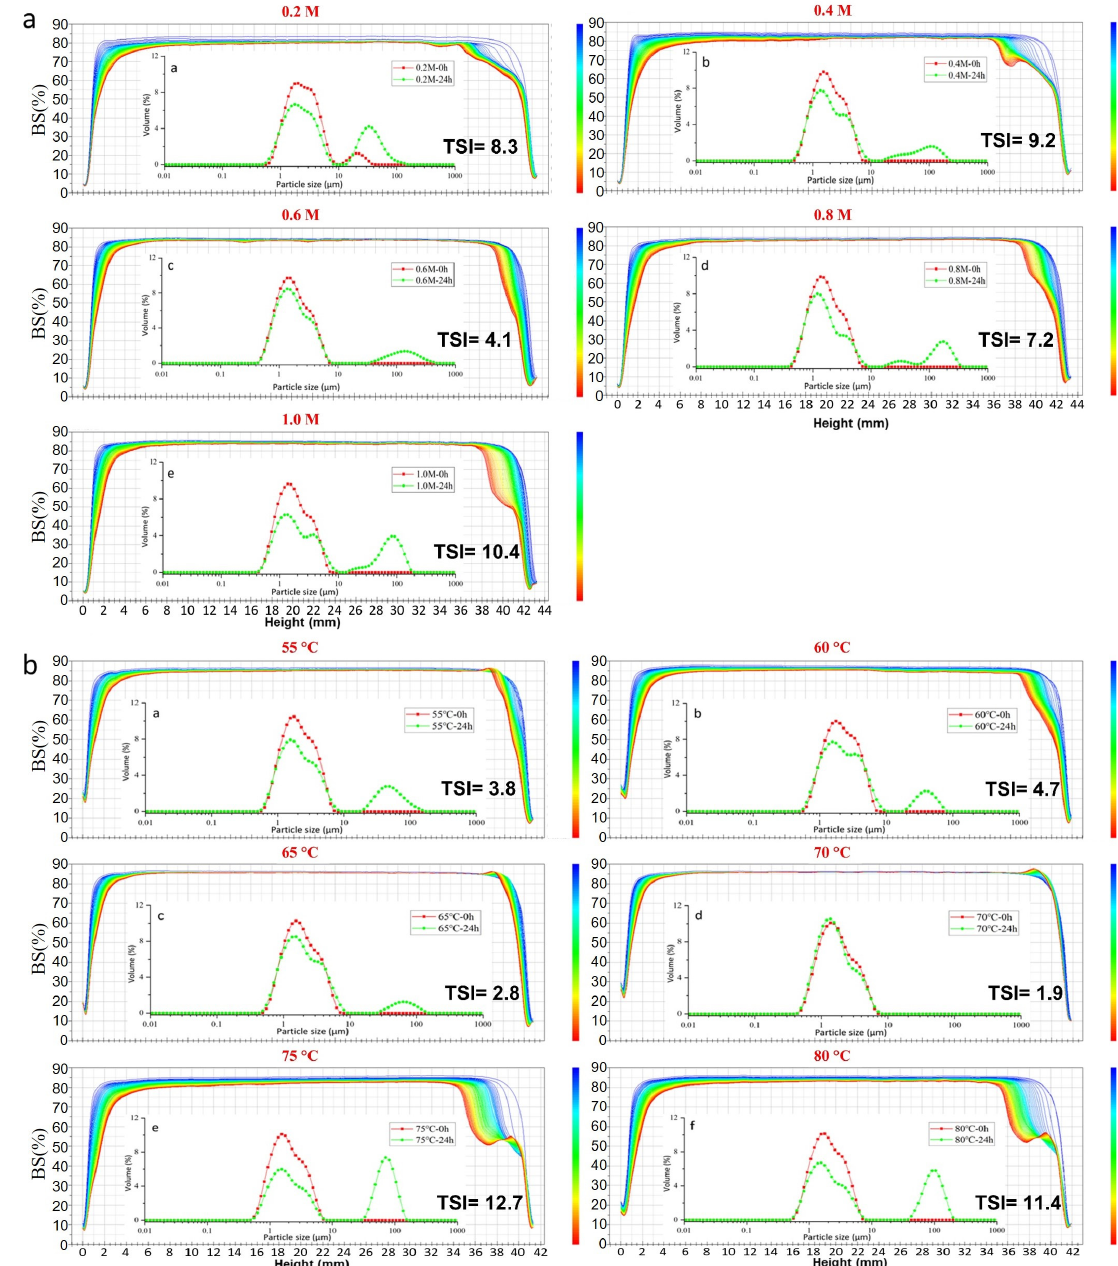
Figure 2. Back-scattered light map and size distribution of emulsions stabilized by ZHCs (a–e in ( a ) represent samples treated with 0.2 M, 0.4 M, 0.6 M, 0.8 M and 1.0 M NaOH at 70 °C, respectively) and ZHTs (a–f in ( b ) represent samples treated with 0.6 M NaOH at 55 °C, 60 °C, 65 °C, 70 °C, 75°C and 80 °C, respectively).